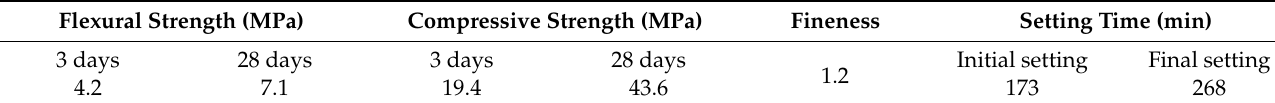
Table 1. Mechanical properties of Portland cement.